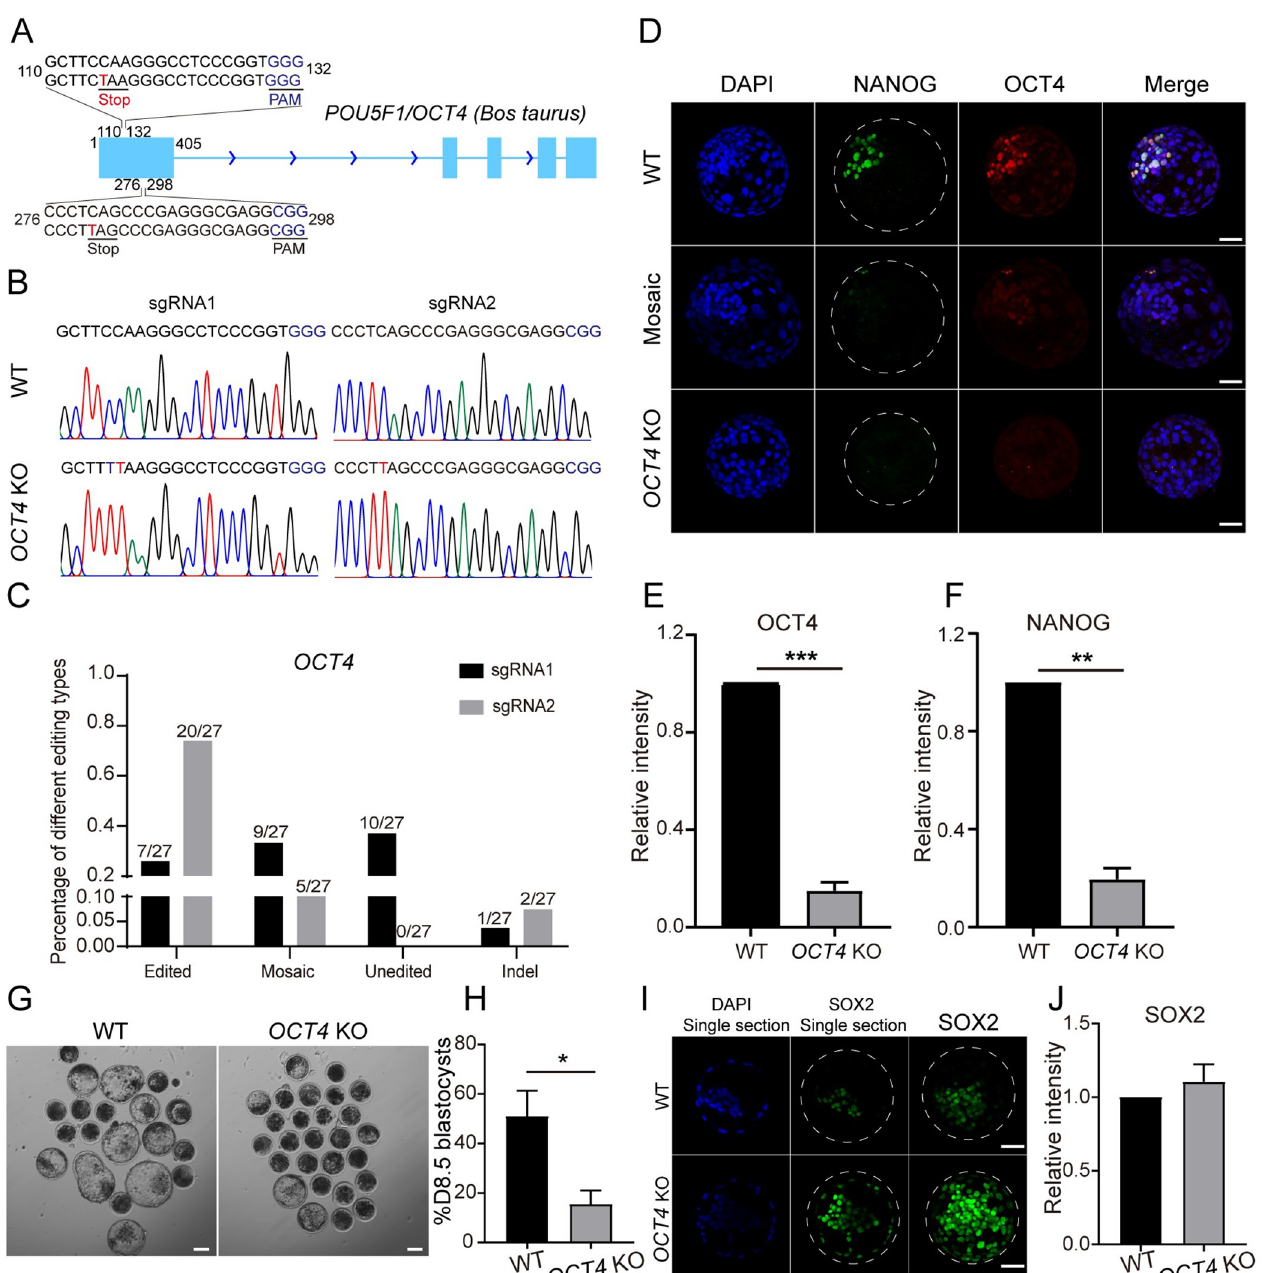
Fig 1. Effects of OCT4 knockout on bovine early embryonic development. A. Two sgRNAs designed to target OCT4 . The red letters represent potential editing sites. The blue letters represent PAM sequences. B. Representative Sanger sequencing results. The red letters represent editing sites. C. Editing types of OCT4 sgRNA1 and sgRNA2 (27 embryos were analyzed). D-F. Immunostaining detection of OCT4 and NANOG in D8.5 WT and OCT4 KO groups (Two replicates of 4–6 blastocysts per group). Green: NANOG; Red: OCT4. Scale bar = 50 μ m. G and H: OCT4 KO results in the decrease of blastocyst rate at D8.5 (Three replicates of 20–25 embryos per group). Scale bar = 100 μ m. I and J. Immunostaining analysis of SOX2 expression and distribution in D8.5 blastocysts (Two replicates of 4–6 blastocysts per group). Green: SOX2; Red: OCT4. Scale bar = 50 μ